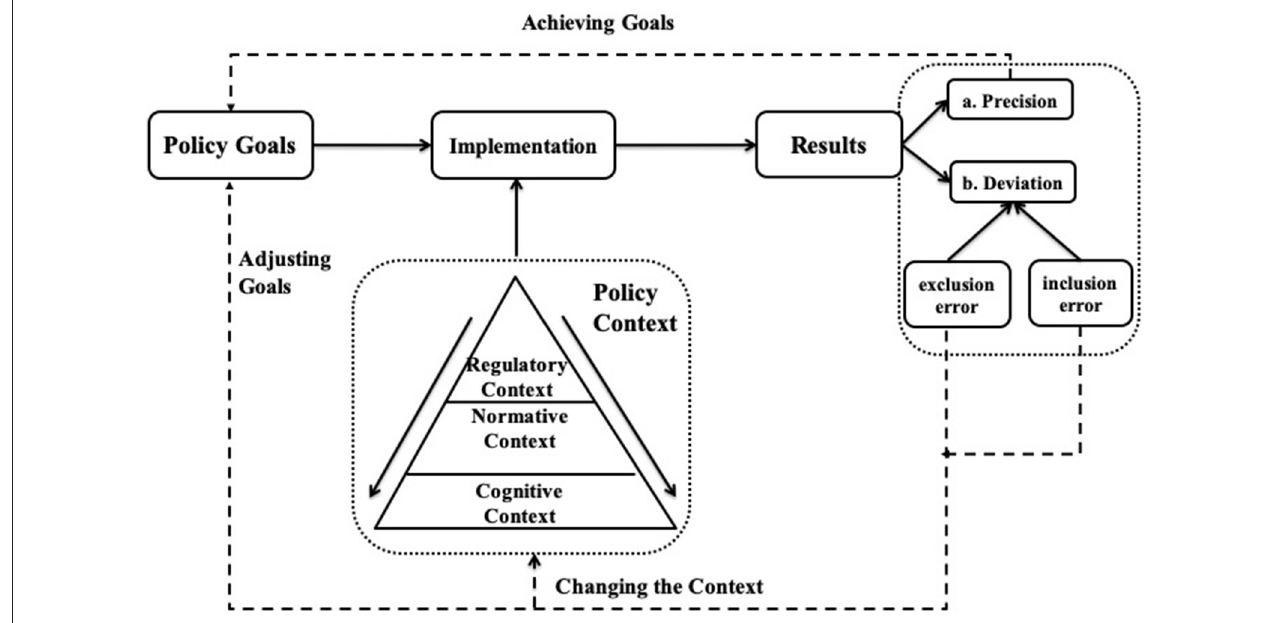
FIGURE 1 | The policy context and its deviations in RASDC